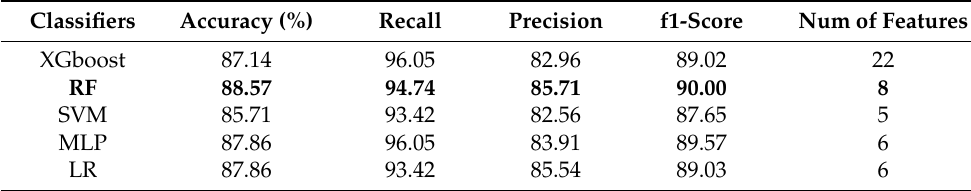
Table 1. Best scores of the competitive classifiers.